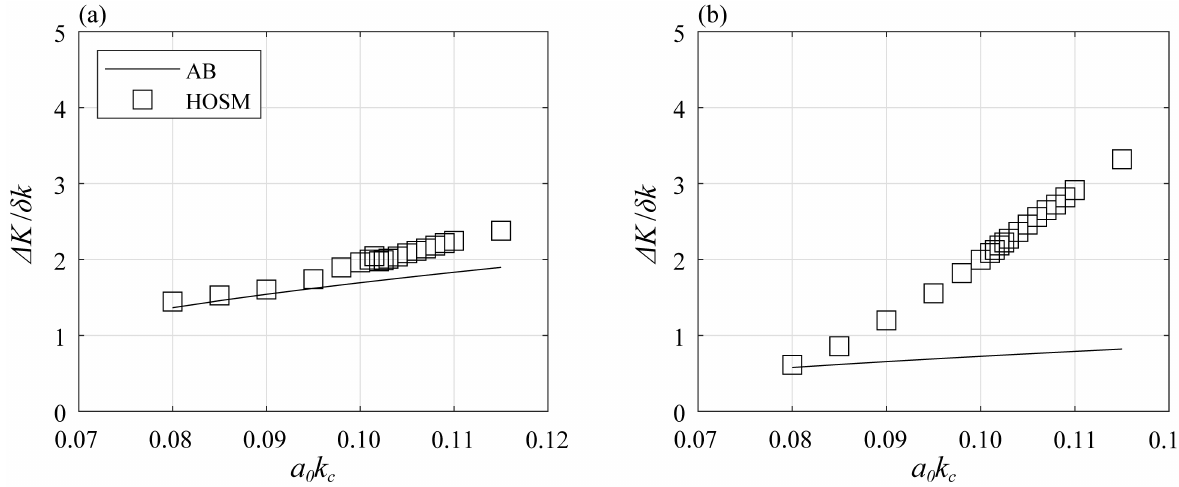
Figure 9. Relation between the initial wave steepness a 0 k c and mean wavenumber difference ∆ K / δ k at t = t max for the modulated wave train. ( a ) Free wave; ( b ) bound